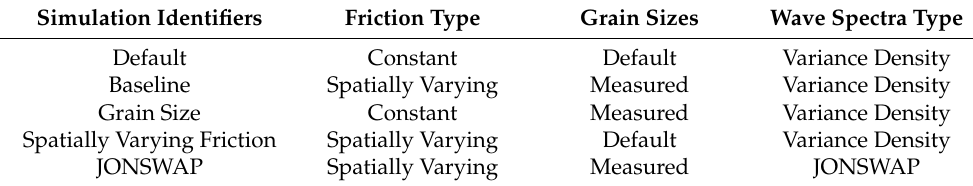
Table 4. Major parameters changed for the simulations